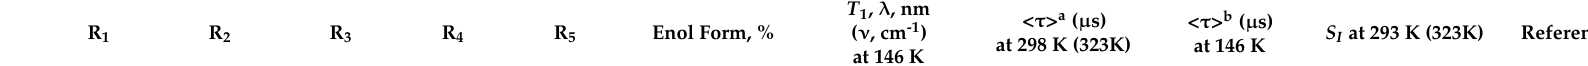
Table 1. The content (%) of enol tautomer for calix[4]arenes in CDCl 3 (0.03M), energies of lowest triplet states ( T 1 ) of the ligands in the Tb 3+ complexes, average lifetimes of the Tb 3+ -centered luminescence (< τ > a ) and ligand-centered phosphorescence of the Gd 3+ complexes (< τ > b ), as well as relative thermal sensitivity ( S I ) values at various temperatures in